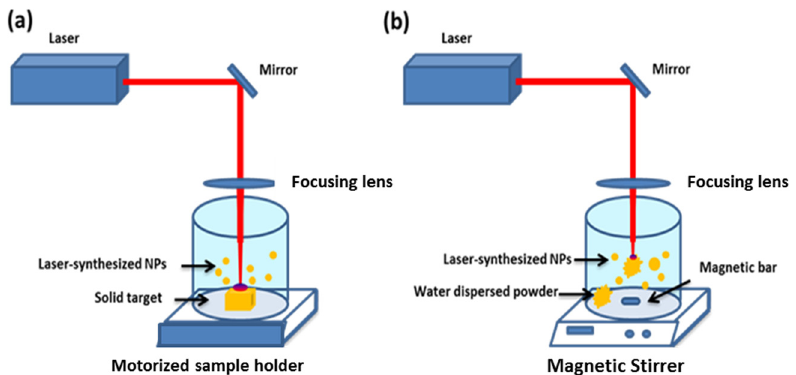
Figure 1. Principle of laser-based nanoparticles (NPs) synthesis via successive steps of ( a ) generation through ablation and ( b ) size-tuning via fragmentation.